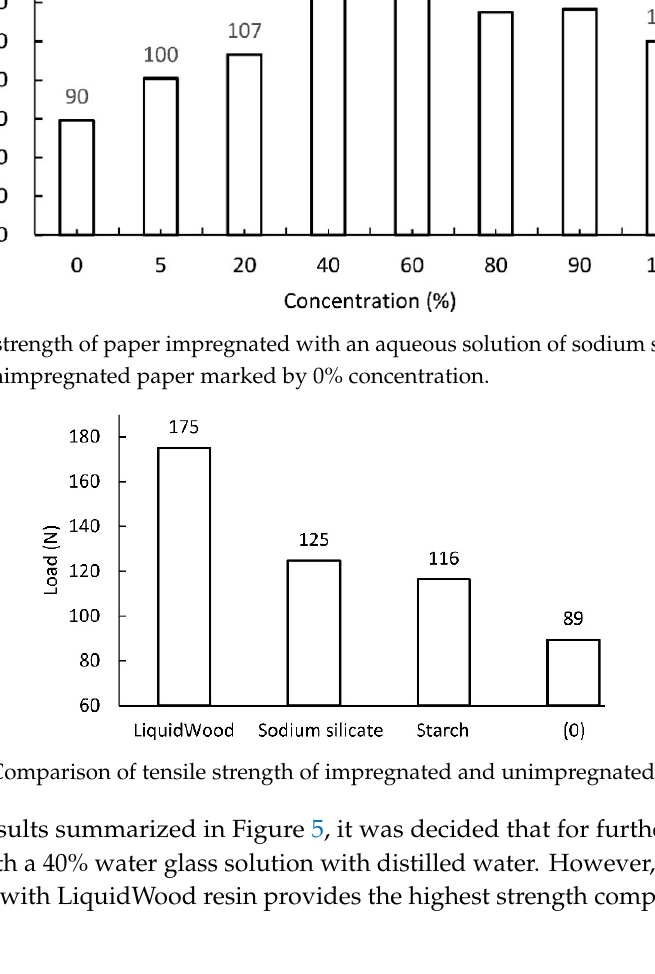
Figure 4. Tensile strength of paper impregnated with modified starch of varying concentration. Unimpregnated paper marked by 0% concentration.